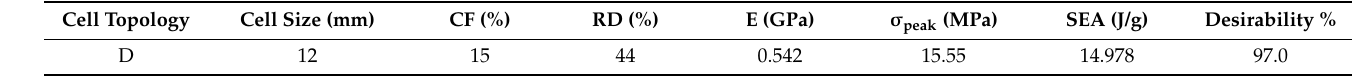
Table 13. Optimal parameter settings obtained by multi-objective desirability analysis.